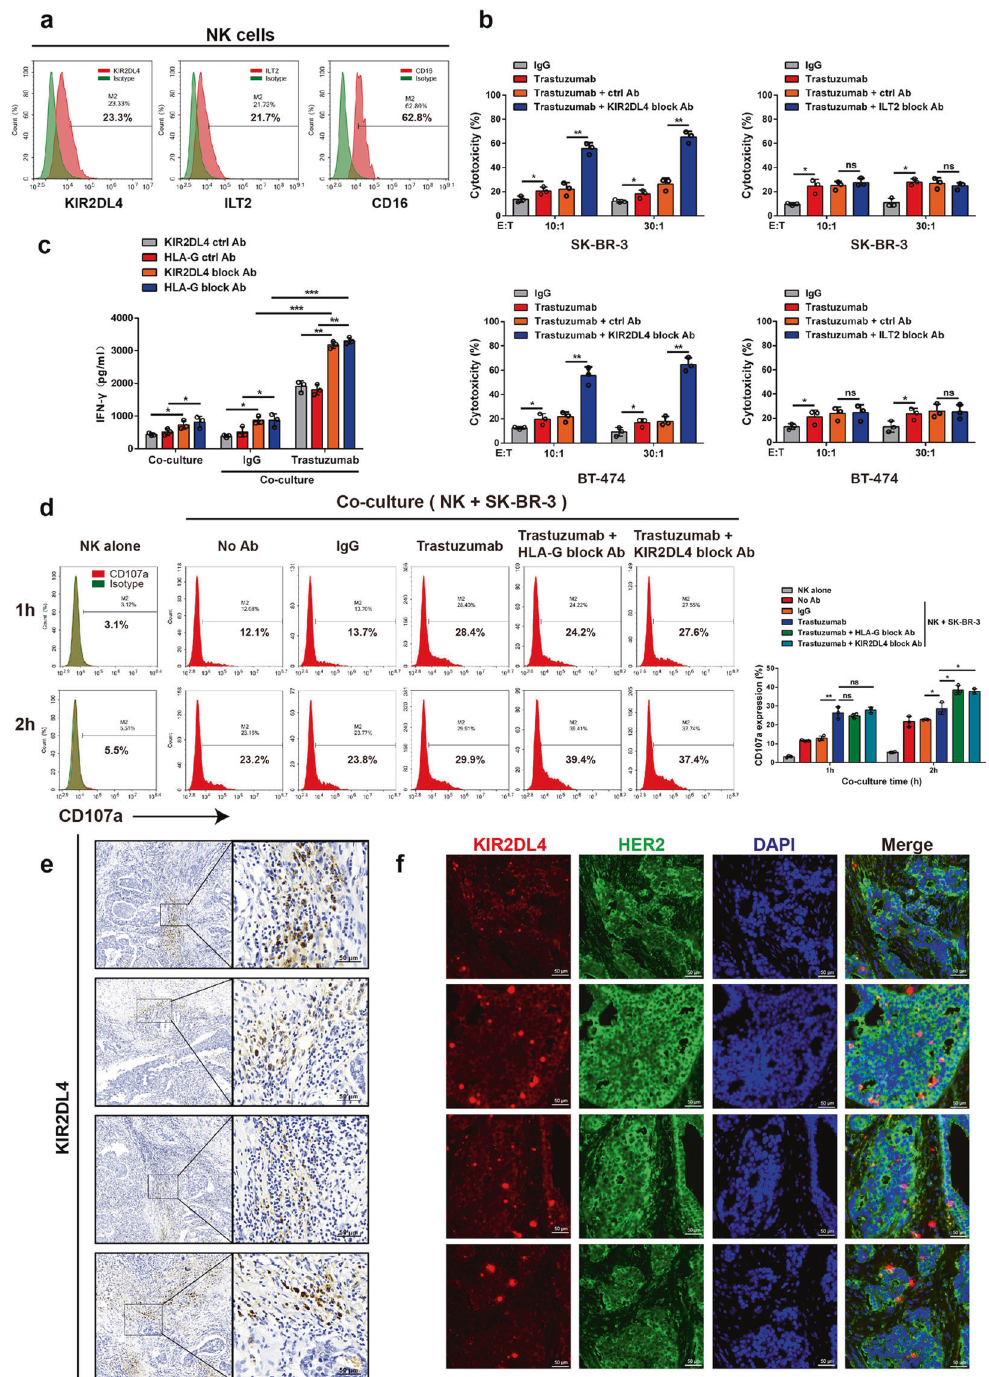
Fig. 2 HLA-G engages KIR2DL4 on NK cells to suppress trastuzumab-elicited ADCC. a FCM assay of the expression of the indicated receptors on human PBMC-derived primary NK cells. b NK cells in the presence of trastuzumab were cocultured with HER2-overexpressing breast cancer cells at the indicated E:T ratios supplemented with or without the indicated blocking antibodies. The toxicity of NK cells to malignant cells was measured. c , d NK cells and SK-BR-3 cells were cocultured as described in ( b ) (E:T = 30:1). IFN- γ production was measured via ELISA ( c ), and the degranulation of NK cells was evaluated via FCM assay for CD107a expression ( d ). e Representative immunohistochemical staining of KIR2DL4 on in fi ltrating NK cells in clinical HER2-positive breast cancer tissues. f Representative immuno fl uorescent staining of HER2 and KIR2DL4 in breast cancer tissues of individual patients. All experiments were performed three times. Statistical signi fi cance was obtained by Student ’ s t test. * P < 0.05, ** P < 0.01, and *** P < 0.001. n.s. Nonsigni fi cant